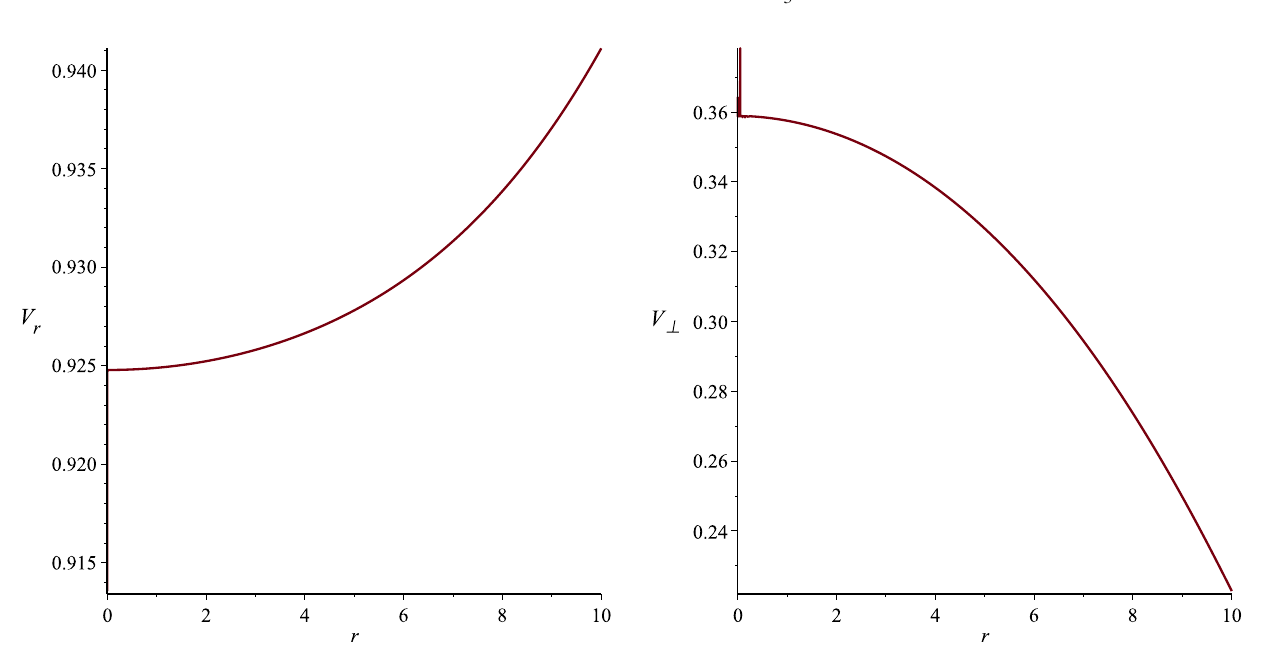
Fig. 6 Radial and transverse velocities versus r in